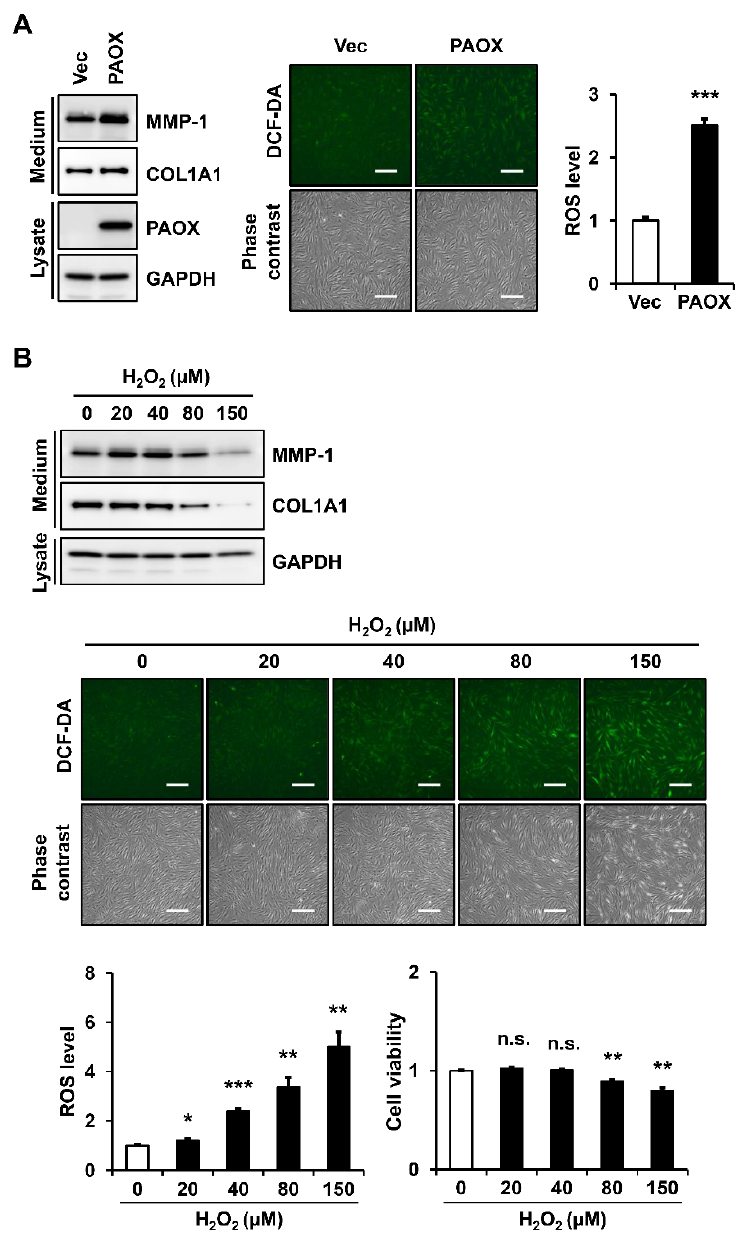
Figure 7. Effect of PAOX expression on reactive oxygen species (ROS) generation in fibroblasts. ( A ) Fibroblasts infected with GFP-deleted vector viruses or GFP-deleted PAOX viruses were incubated in a serum-free and phenol-red-free DMEM for 24 h. ( B ) Fibroblasts were incubated in a serum-free and phenol-red-free DMEM for 24 h in the presence of various concentrations of hydrogen peroxide (H 2 O 2 ). Conditioned media and cell lysates were analyzed using Western blotting with anti-MMP-1, anti-pN-COL1A1, anti-PAOX, and anti-GAPDH antibodies. Intracellular ROS levels were detected by green fluorescence at 525 nm after staining with 10 µM DCF-DA for 30 min. ROS levels were assessed using the ImageJ software, normalized with cell numbers counted by crystal violet staining, and shown in graphs relative to the ROS levels in ( A ) vector-infected cells or ( B ) untreated cells. Cell viability was measured by the crystal violet staining and depicted in a graph relative to that in untreated cells. Each value represents the mean ± standard deviation of three independent experiments. * p < 0.05, ** p < 0.01, and *** p < 0.001 vs. control. n.s.: not significant. Magnification: ×100. Bar = 200 µm.